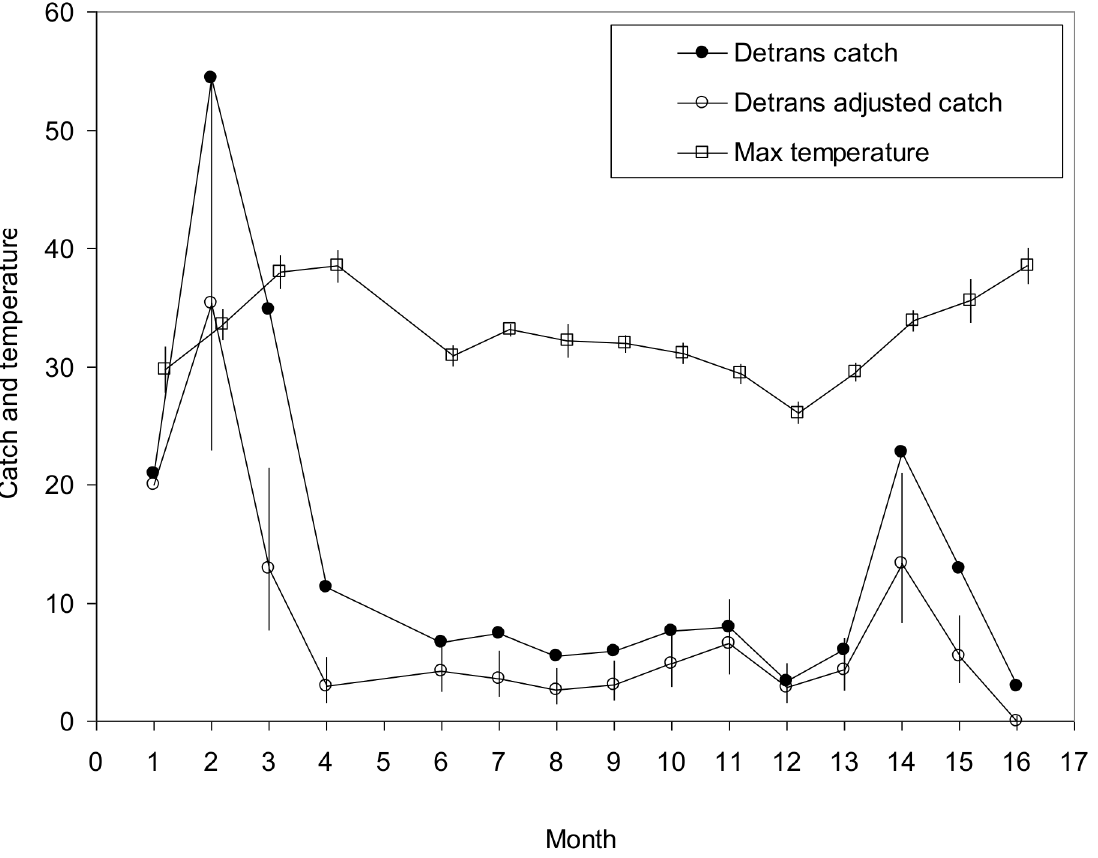
Figure 1. Monthly temperatures and catches from the house. Monthly data for detransformed mean daily catches of all tsetse from the house, mean maximum temperature, and detransformed catches adjusted for the effect of temperature. Bars through means indicate 95% confidence limits.